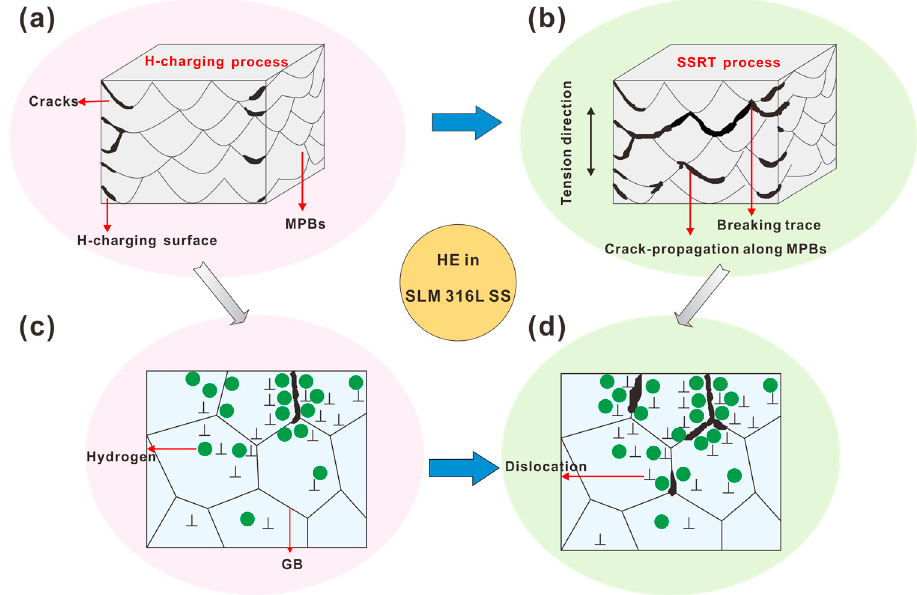
Figure 10. Schematic illustration of the crack growth routes along the MPBs with ( a , c ) H ‐ charging process and ( b , d ) SSRT